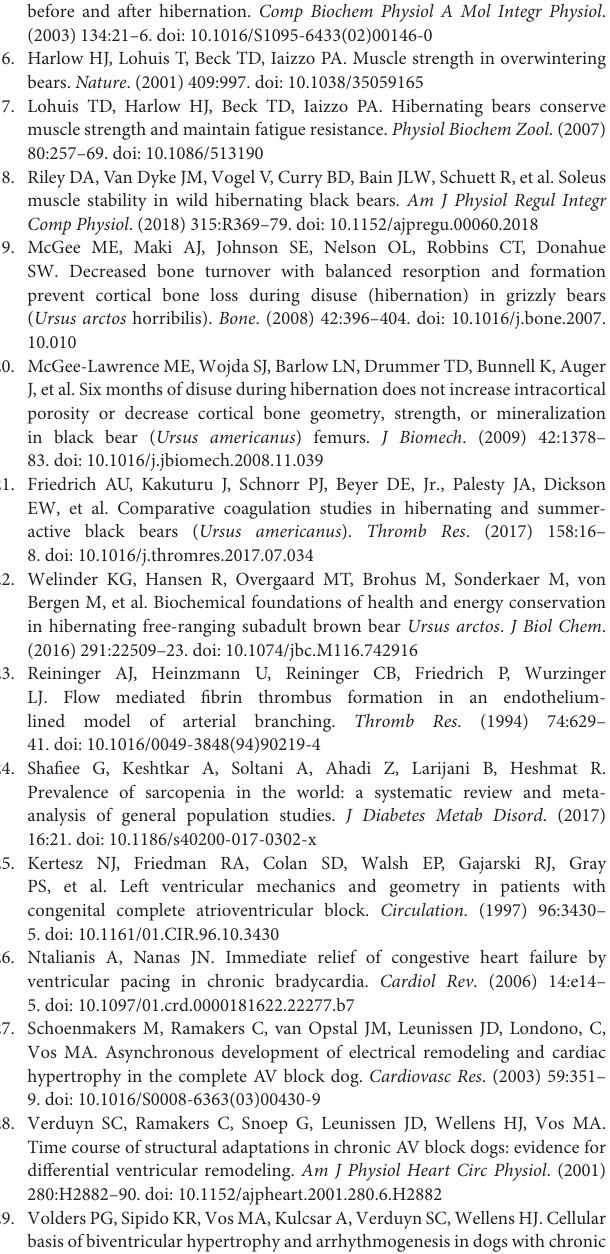
Supplementary Table 1 | Bear serum characteristics: Description of different bear serum mix, with single bear ID number, Year of collection, Age, Gender and the protein content of each seasonal mix bear serum. Mean of protein content (mg/ml) ±